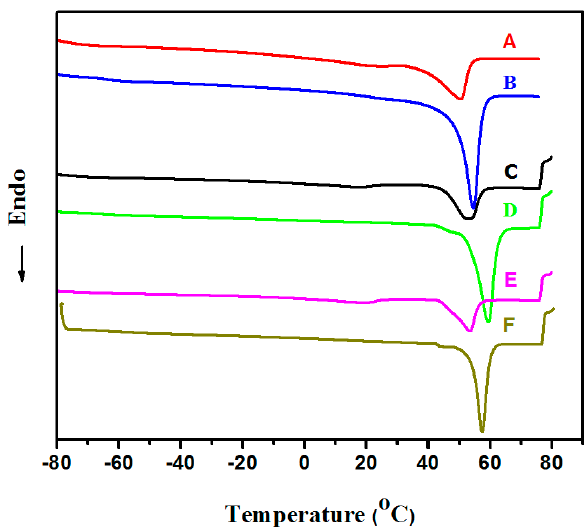
Figure 3. DSC curves of the electrospun mats of P1 ( A in red) and P2 ( B in blue), P1 annealed ( C in black) and P2 annealed ( D in green ) after annealing at 47 °C, P1 cast film ( E in magenta) and P2 cast film ( F in dark yellow).